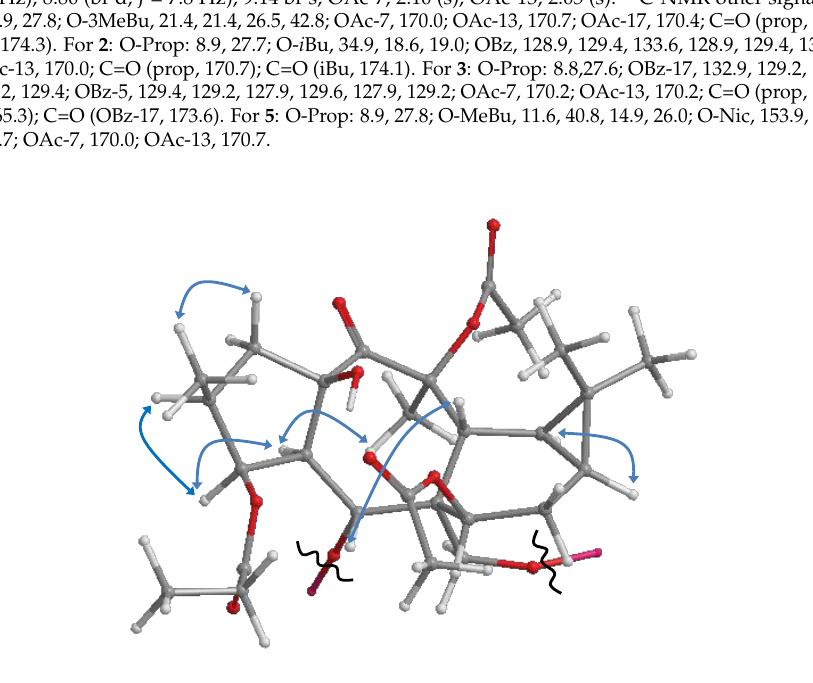
Figure 3. Observed NOESY correlations for 1 – 4 .